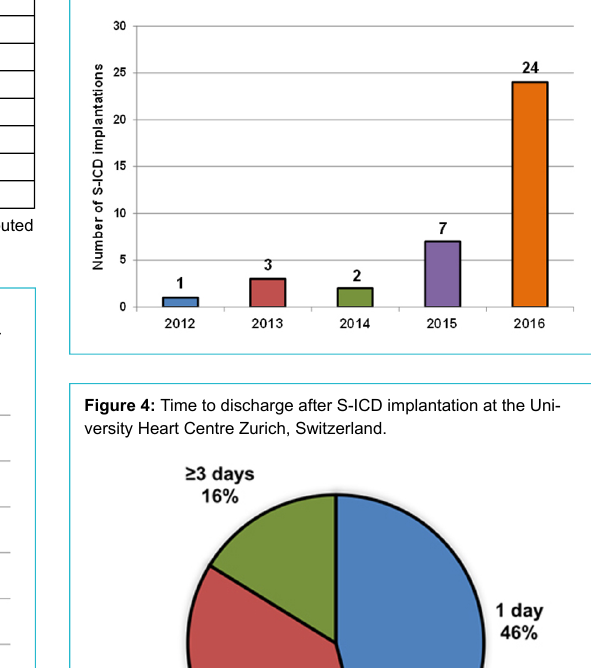
Figure 3: Number of S-ICD implantations from 2012 to 2016 at the University Heart Centre Zurich, Switzerland.